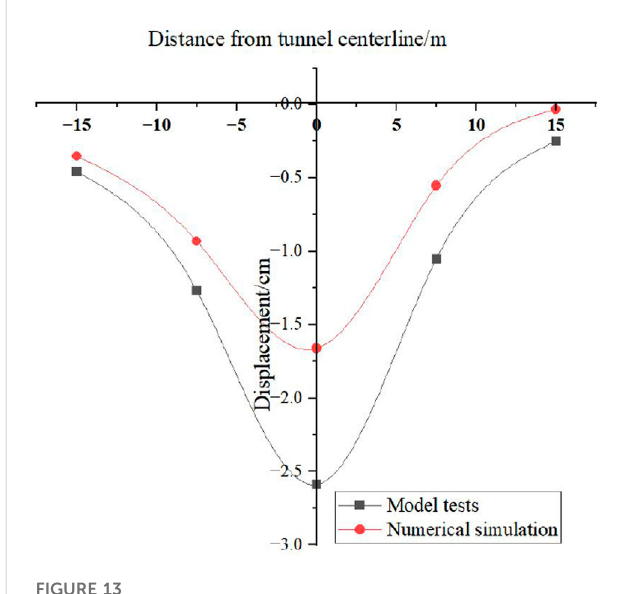
FIGURE 13 Vertical displacement of surrounding rock